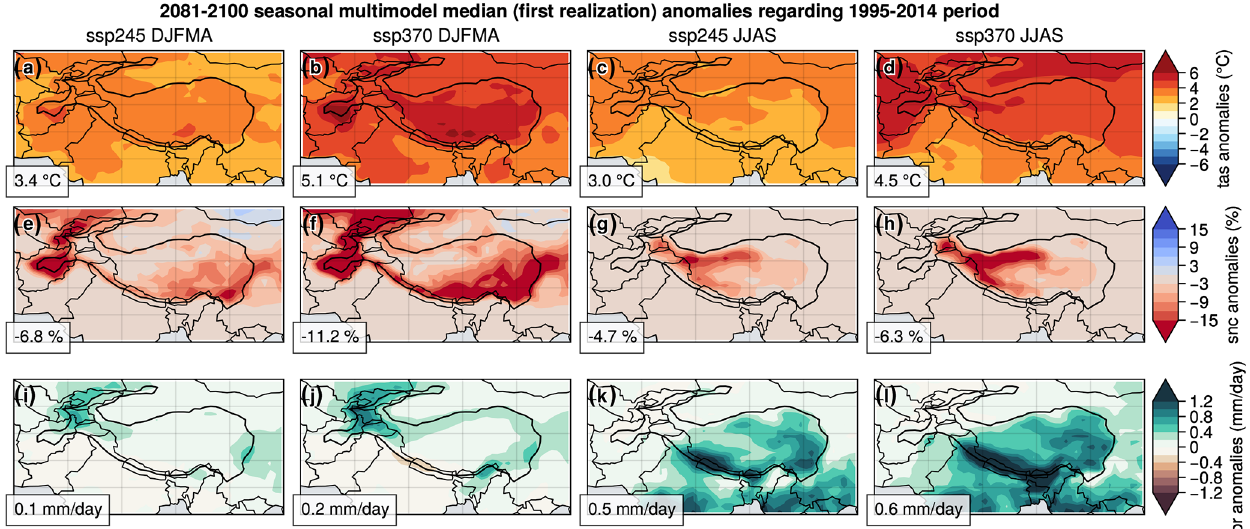
Figure 10. Median of the model differences between the 2081–2100 and the 1995–2014 averages for temperature (a–d) , snow cover (e–h) and precipitation (i–l) under the SSP2-4.5 and SSP3-7.0 scenarios. The first realization is used for each model. The black contour corresponds to the HMA domain ( > 2500m) for which the spatial average is shown in the lower left